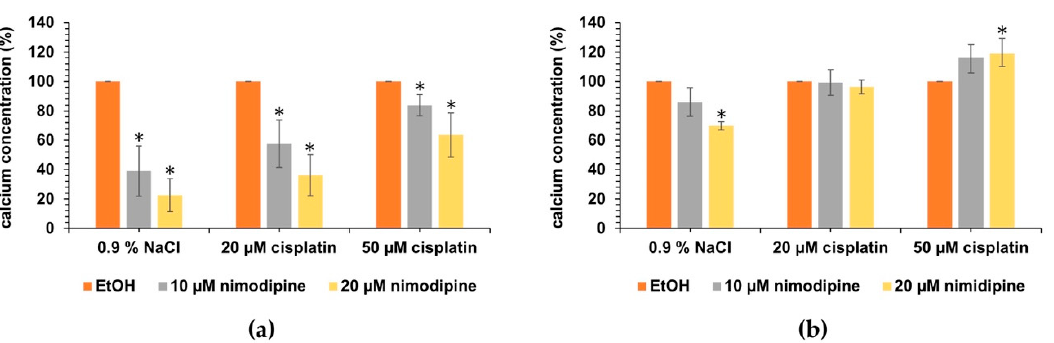
Figure 6. Intracellular calcium amount under cisplatin stress of nimodipine pre-treated UB/OC − 1 ( a ) and UB/OC − 2 ( b ) cells. The 1 × 10 4 cells were seeded in black flat 96-well plates and treated as described in method section. Detection of intracellular calcium by the fluorescent dye Cal-520 showed a decrease by nimodipine pre-treatment in UB/OC − 1 cells that was reduced with increasing cisplatin concentration. Examination of nimodipine-treated UB/OC − 2 cells initially showed a de- crease in the amount of calcium without stress induction (0.9% NaCl), which was minimally visible at 20 µM cisplatin and changed to an increase at 50 µM. The graphs show the results of three inde- pendent biological replicates. If the p values were < 0.05 (* p < 0.05) compared to the solvent